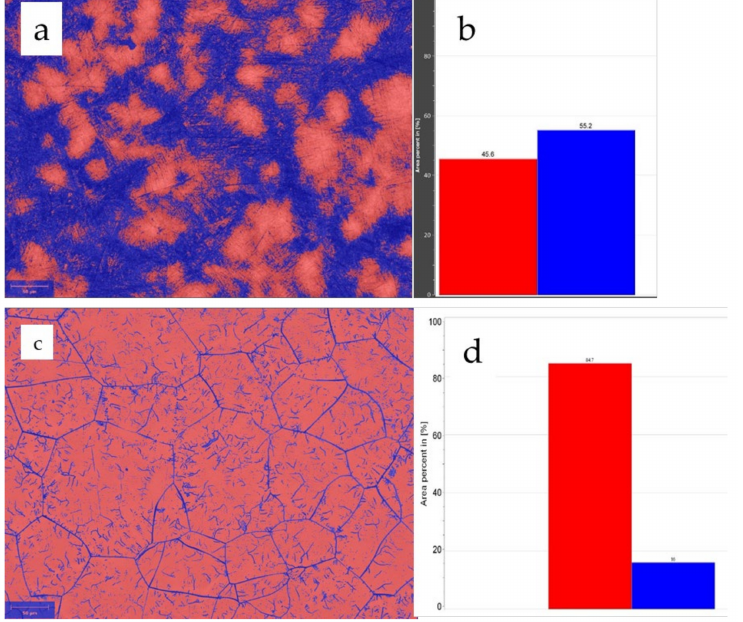
Figure 5. OM microstructure of the alloys: ( a , b ) Ti10Nb10Zr5Ta; ( c , d ) Ti20Nb20Zr4Ta in a cast state. Blue color indicates α -Ti phase while red color indicates β -Ti